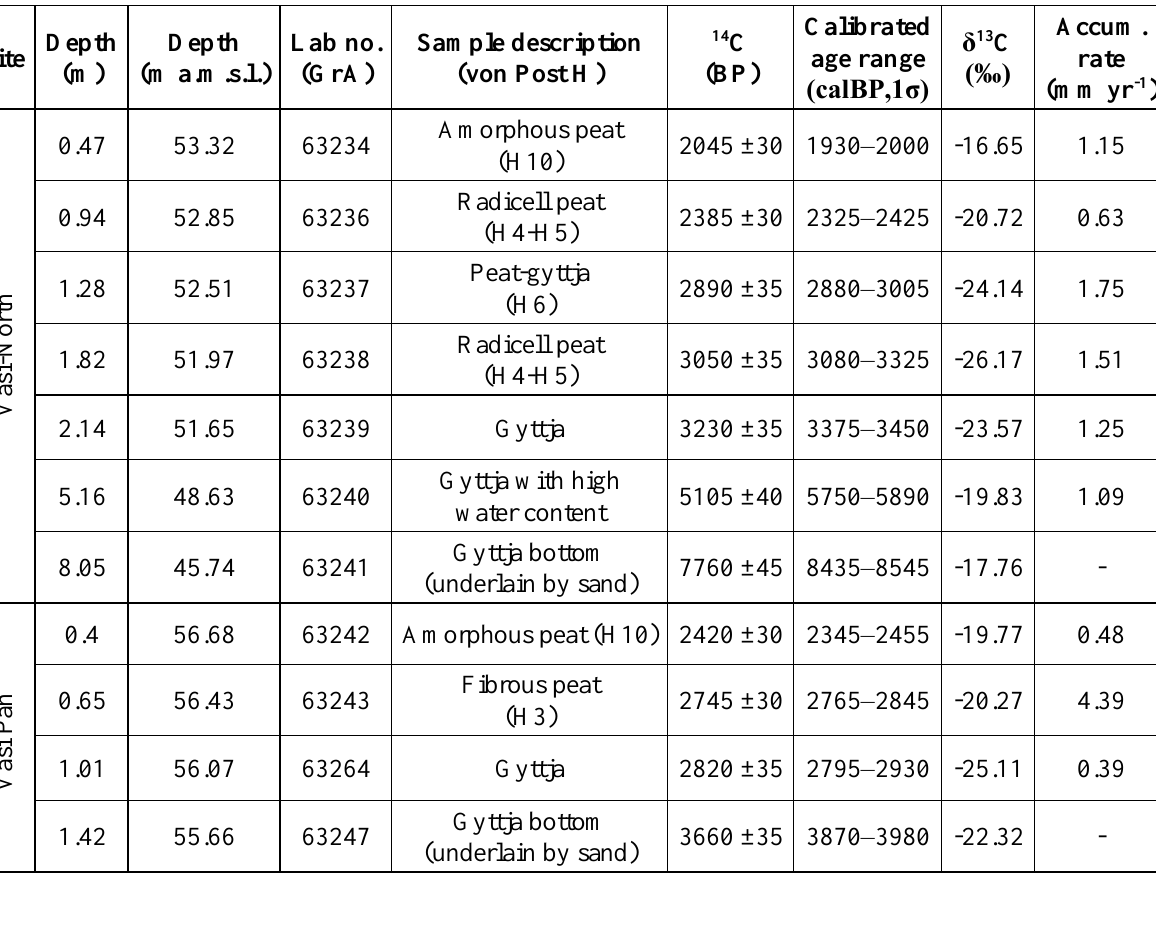
Table 1. List of the measured radiocarbon dates in BP for the peat samples, the δ 13 C values, and the calibrated date range (in calBP, calendar years relative to 1950 AD). The 14 C values were rounded to the nearest 5 calBP. Accumulation rates were calculated using the difference in age per difference in depth.